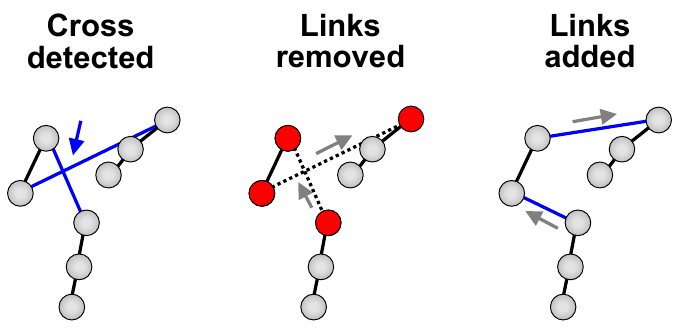
Figure 8. Cross removal heuristic to improve an existing tour. The four end points involved in the cross are re-organized by swapping the end point of the first link with the start point of the second link.